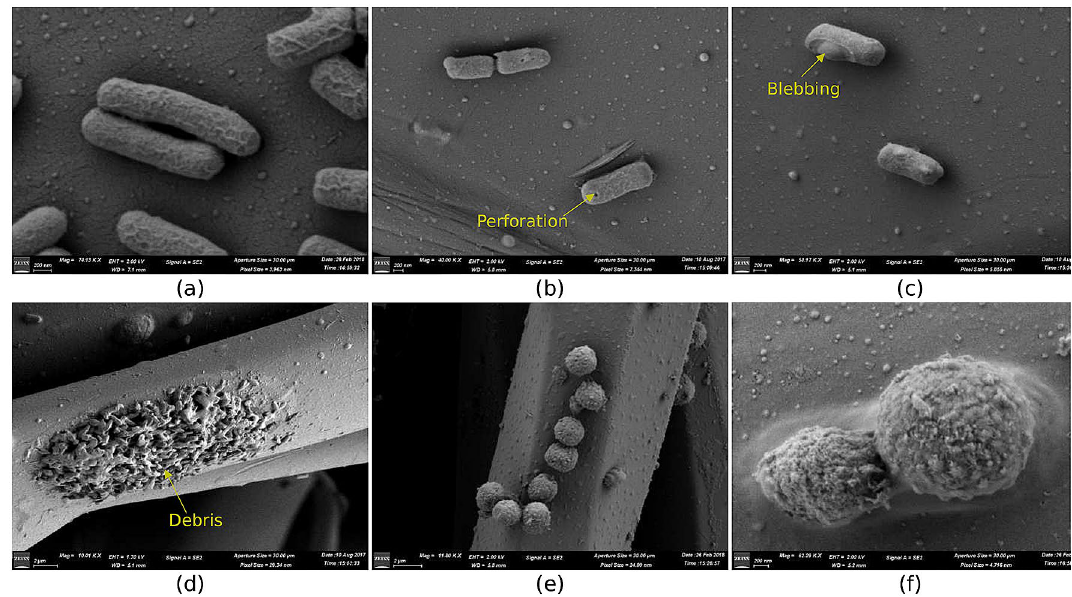
Figure 5. Mechanism of lysing of microbes. ( a ) E. Coli , control. ( b ) E. Coli , after 5 min, showing perforation. ( c ) E. Coli , after 5 min, showing blebbing. ( d ) E. Coli , after 10 min, showing accumulated debris. ( e ) A. Fumigatus ,